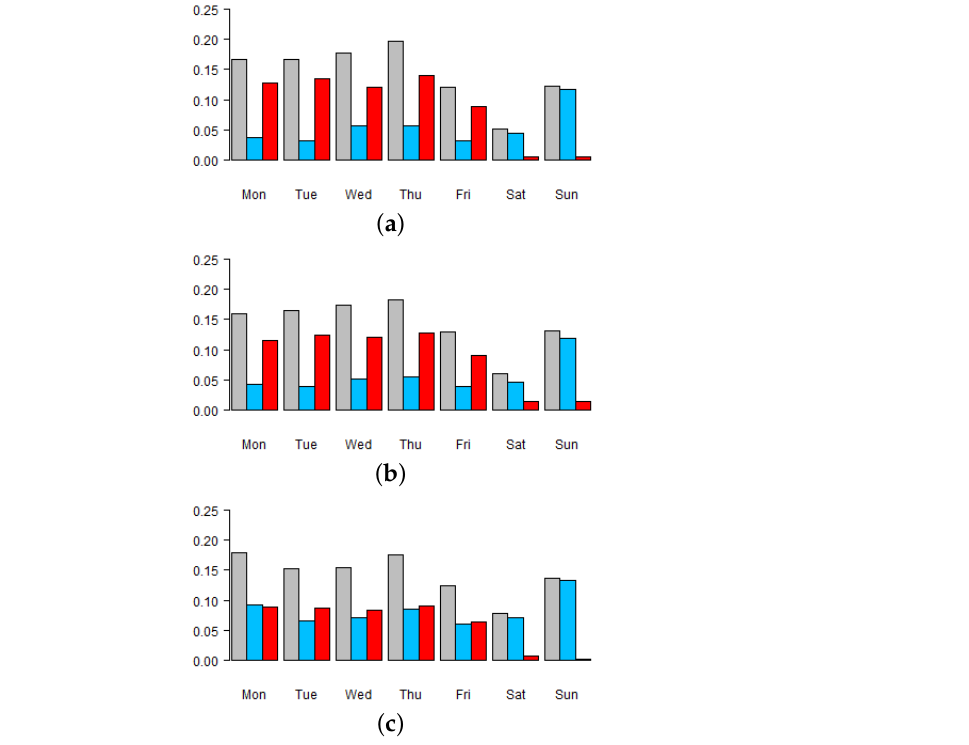
Figure 5. Percentage of electricity price jumps (total in grey, downward in blue, upward in red) on each day of the week detected using: ( a ) the RFP method, ( b ) the Tukey method and ( c ) the adjusted boxplot method, for 24 price series separately (29 December 2014–24 November 2019).